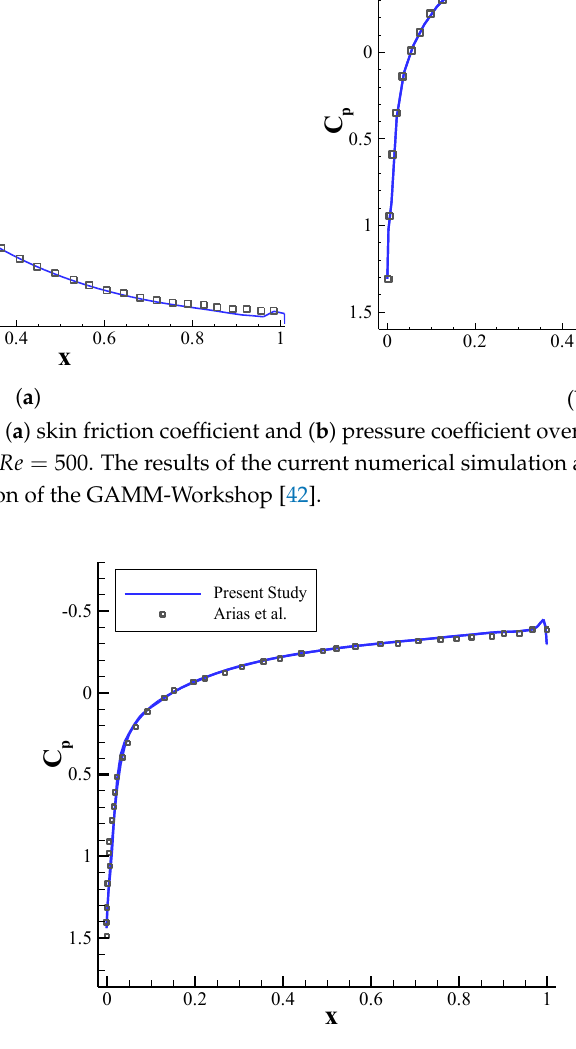
Figure 3. Distribution of the pressure coefficient along the suction side of a NACA 0012 airfoil for inviscid flow with M = 1.2. For comparison purposes, the results of Arias et al. [43] are also